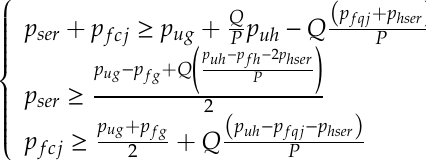
. The Nash equilibria of the three-